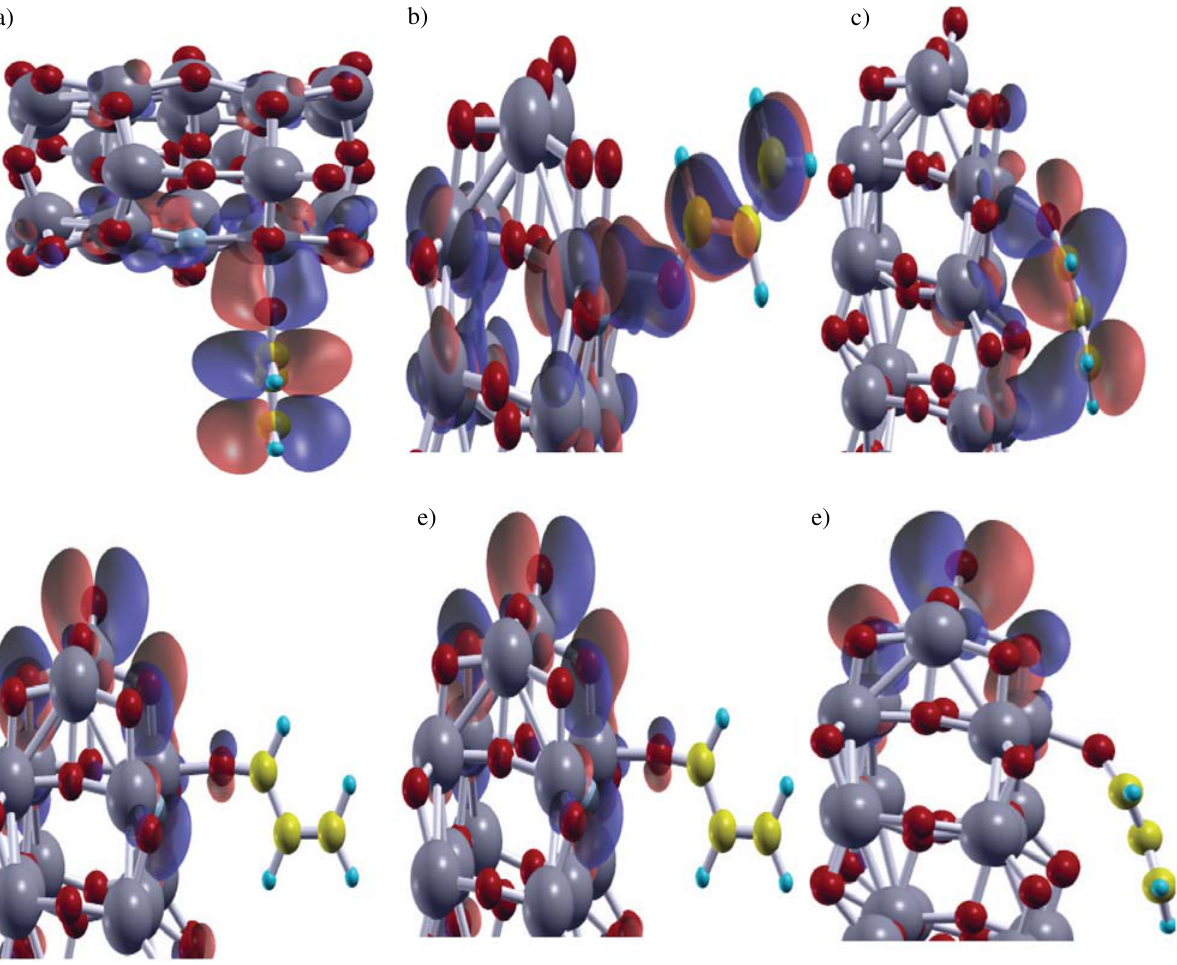
Figure 5. The isosurfaces of HOMO and LUMO molecular orbitals of the systems consisting of the C H O on the considered nanoparticles, a: Complex A2; b: Complex A1; c: Complex A6; d: Complex A2; e: Complex A1; f: Complex A6 3 4